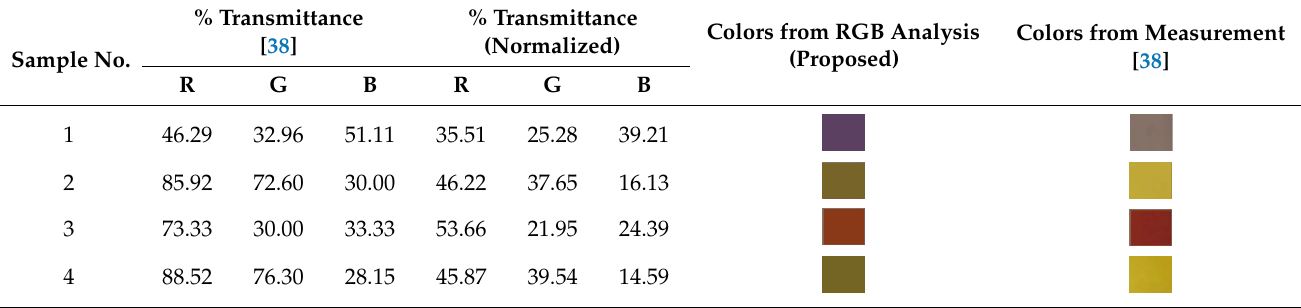
Table 2. Results comparison.